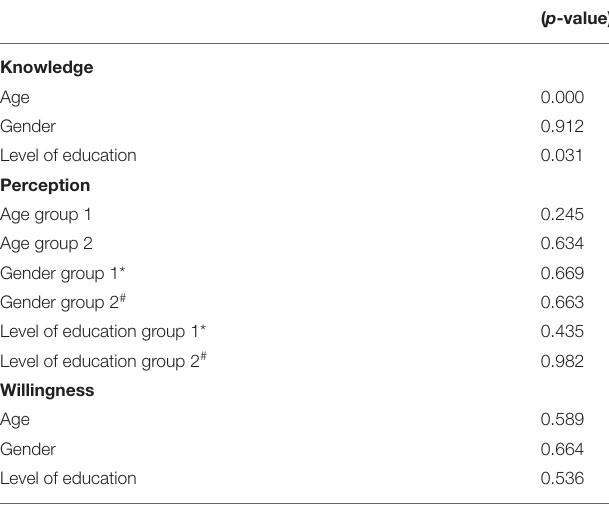
TABLE 4 | Association between demographic characteristics and knowledge, perception, and willingness to use